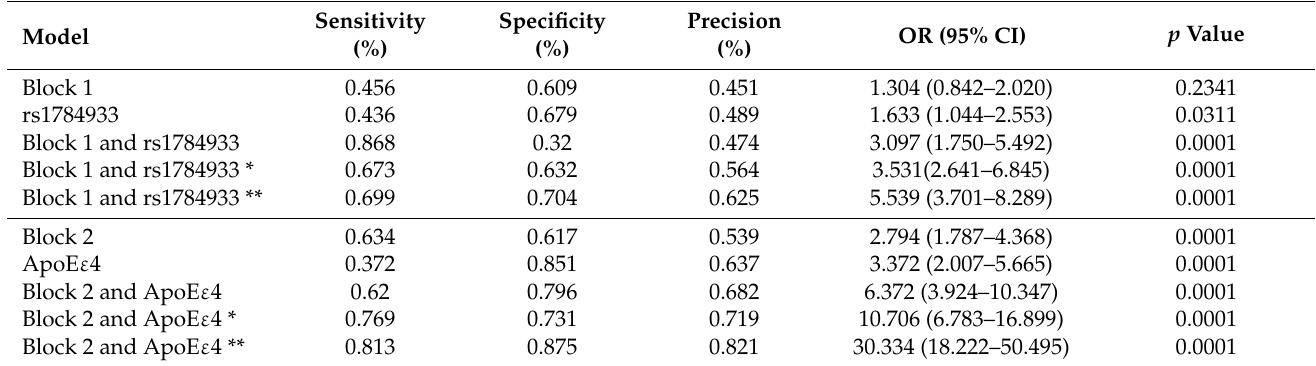
Table 3. Risk assessment according to Haplotypes (Block 1 and 2) using the associated SNPs (rs1784933 and ApoE ε